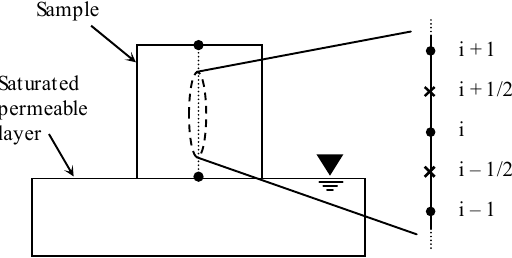
Figure C1. Definition of the points at which the water flow rate was calculated. Figure A1. Definition of the points at which the water flow rate was